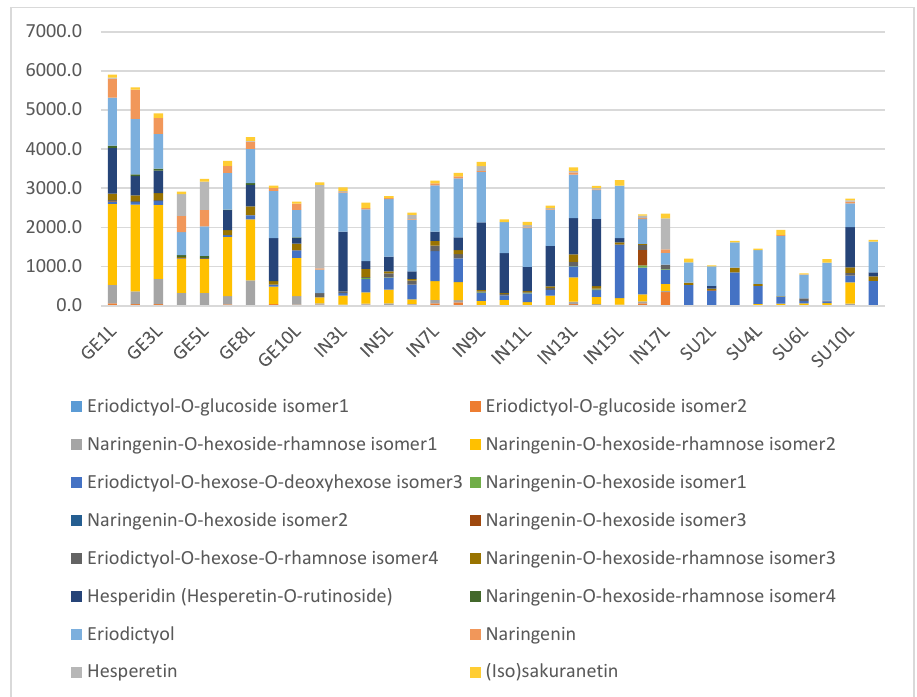
Figure 12. Composition of the flavanones (mg/kg relative to mangiferin) in the leaf samples from the three main commercial sources of honeybush tea: Cyclopia genistoides (GE, nine samples), C. intermedia (IN, 16 samples) and C. subternata (SU, nine samples). For sample codes see Table 2. Numbering is according to the collection point and from West to East in each species.